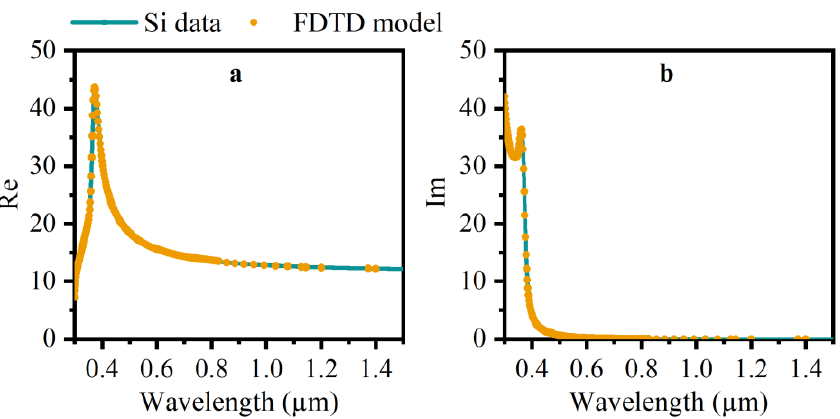
Figure 1. The fitted finite difference time domain ( FDTD) model of refractive index and the material data of silicon (( a ) silicon-n, ( b )